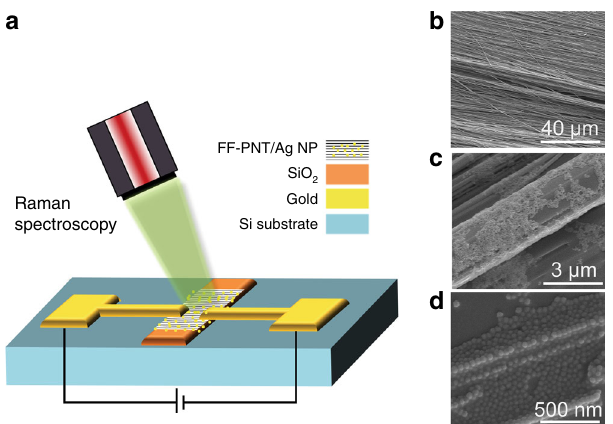
Fig. 1 Substrate fabrication and characterization. a Schematic sketch of the template design that is used in the study. b - d Scanning electron microscopy images of the aligned FF-PNT/Ag NP structures located between the gold